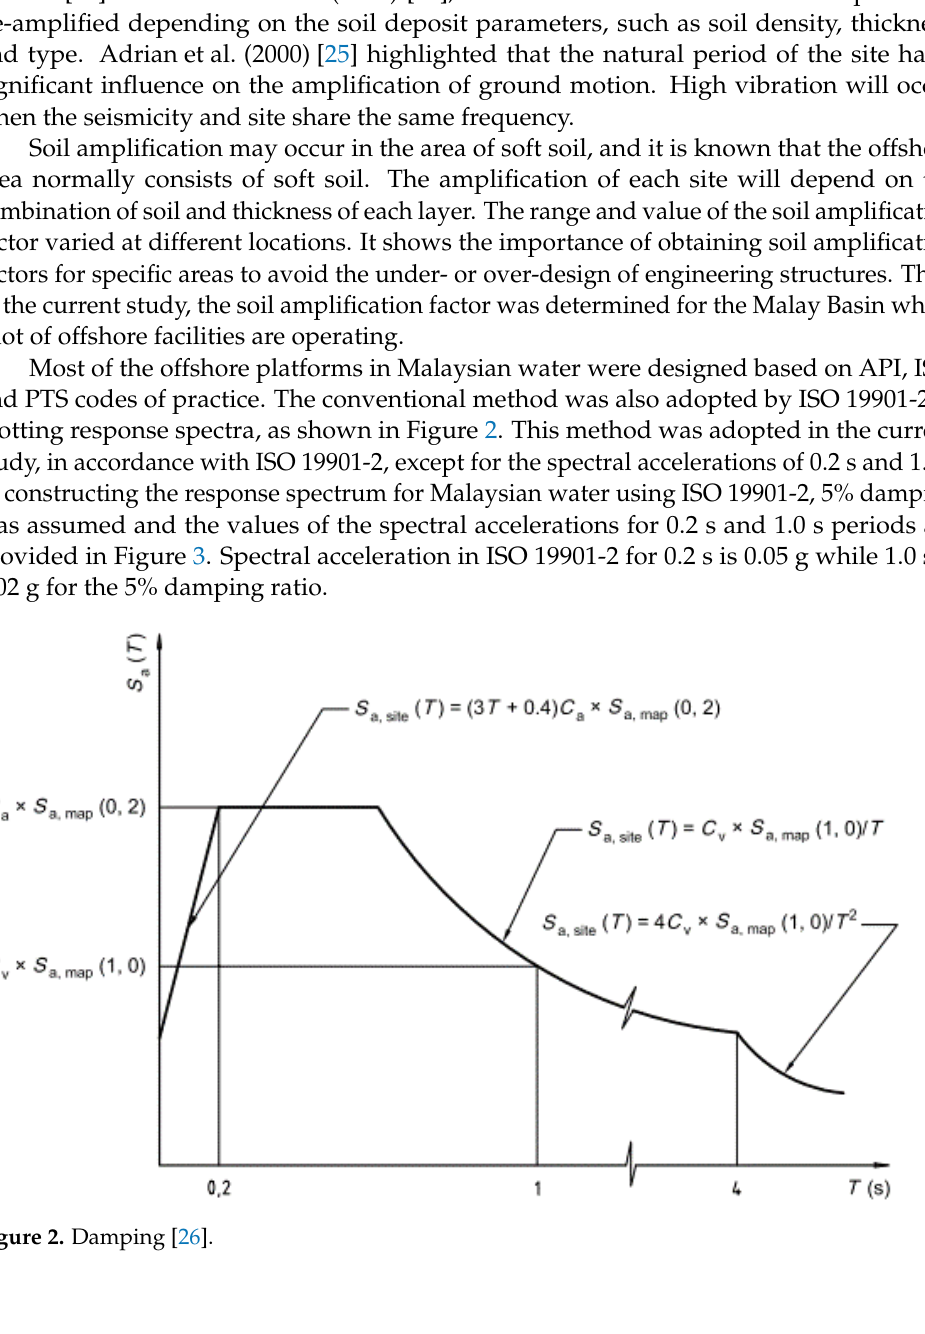
Figure 3. Map of 5% damping spectral response acceleration for offshore Indonesia [26]. According to Freeman (2007) [27], the usefulness of response spectra as a tool in the design and analysis process increased due to the requirement of building codes and ac- ceptable performance-based design (PBD) techniques. Thus, many studies were con- ducted on previous researchers ’ spectral responses due to seismic excitation, and the in- fluence on the structure was also highlighted. Freeman (2007) [27] discussed how seismic